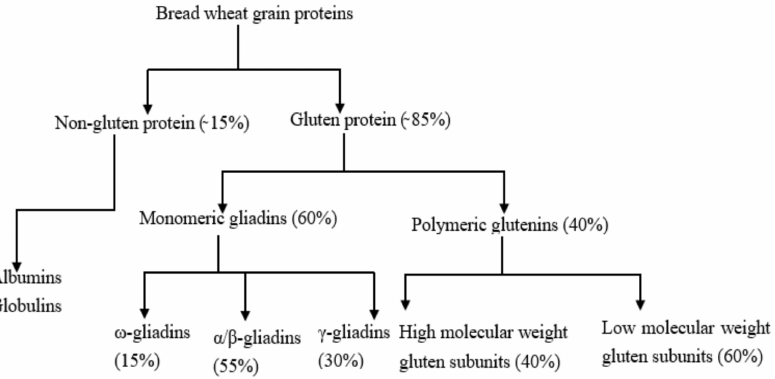
Figure 2. The composition and classification of wheat proteins modified from [25]; Open